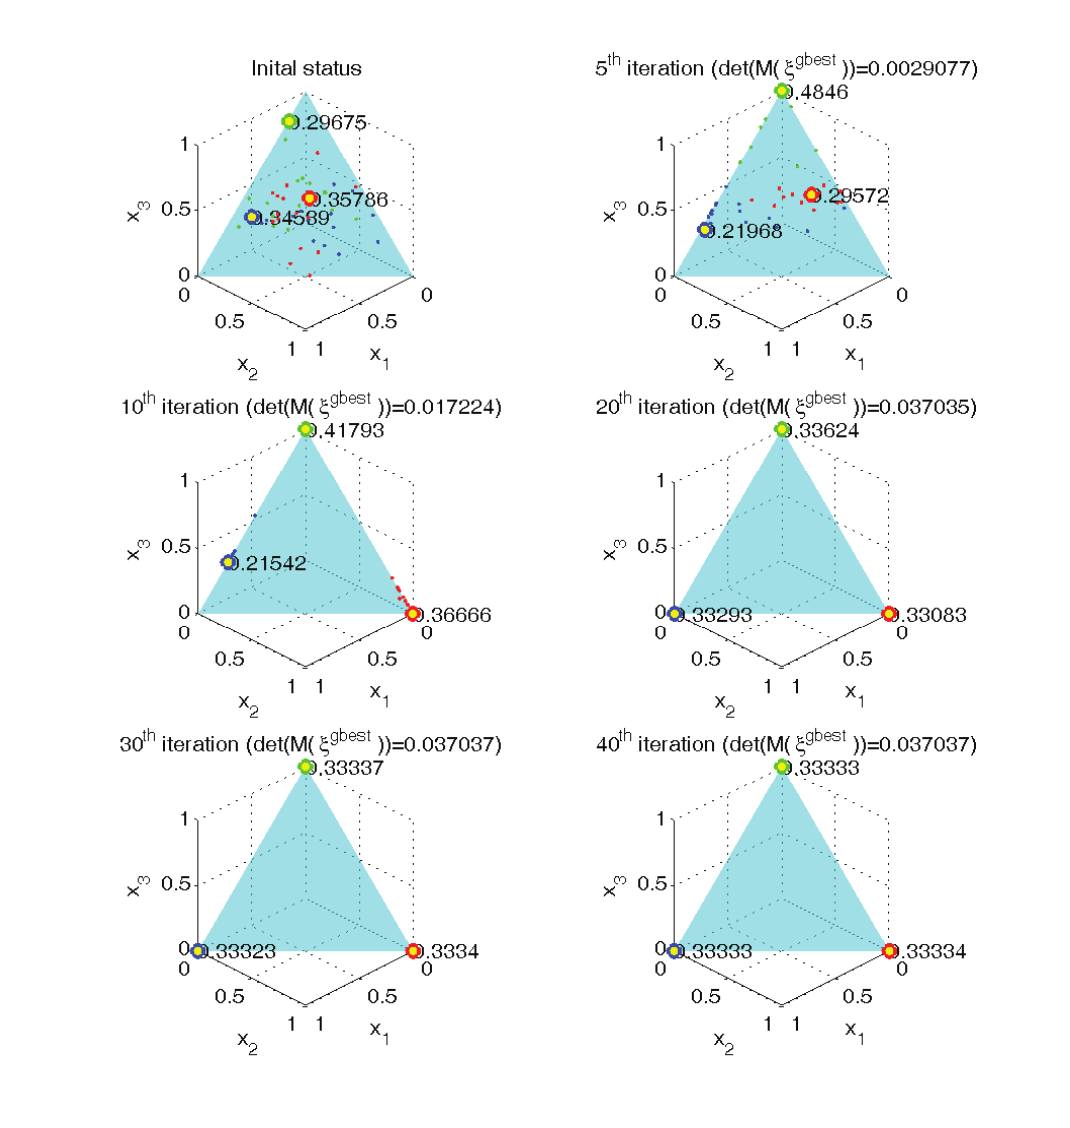
Fig 1. The movement of particles in the ProjPSO search for the D -optimal design for the linear additive mixture model with q = 3 factors. Each sub- figure displays the ProjPSO-generated mixture design or the global best design ξ gbest at a particular iteration. After 40 iterations and only 4 seconds of CPU time, ProjPSO converged to the D -optimal design equally supported at the